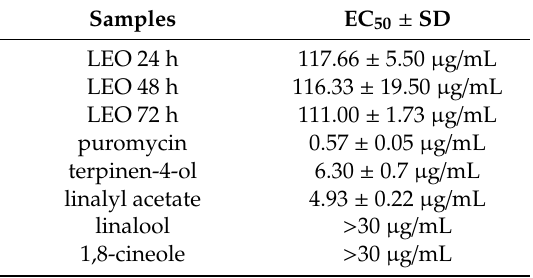
Table 1. EC 50 obtained by a dose-dependent MTT assay after 24, 48, and 72 h of Lavandin Essential Oil (LEO) treatments and after 24 h of main compound treatments on HL60 cells. The values are expressed as the mean ±